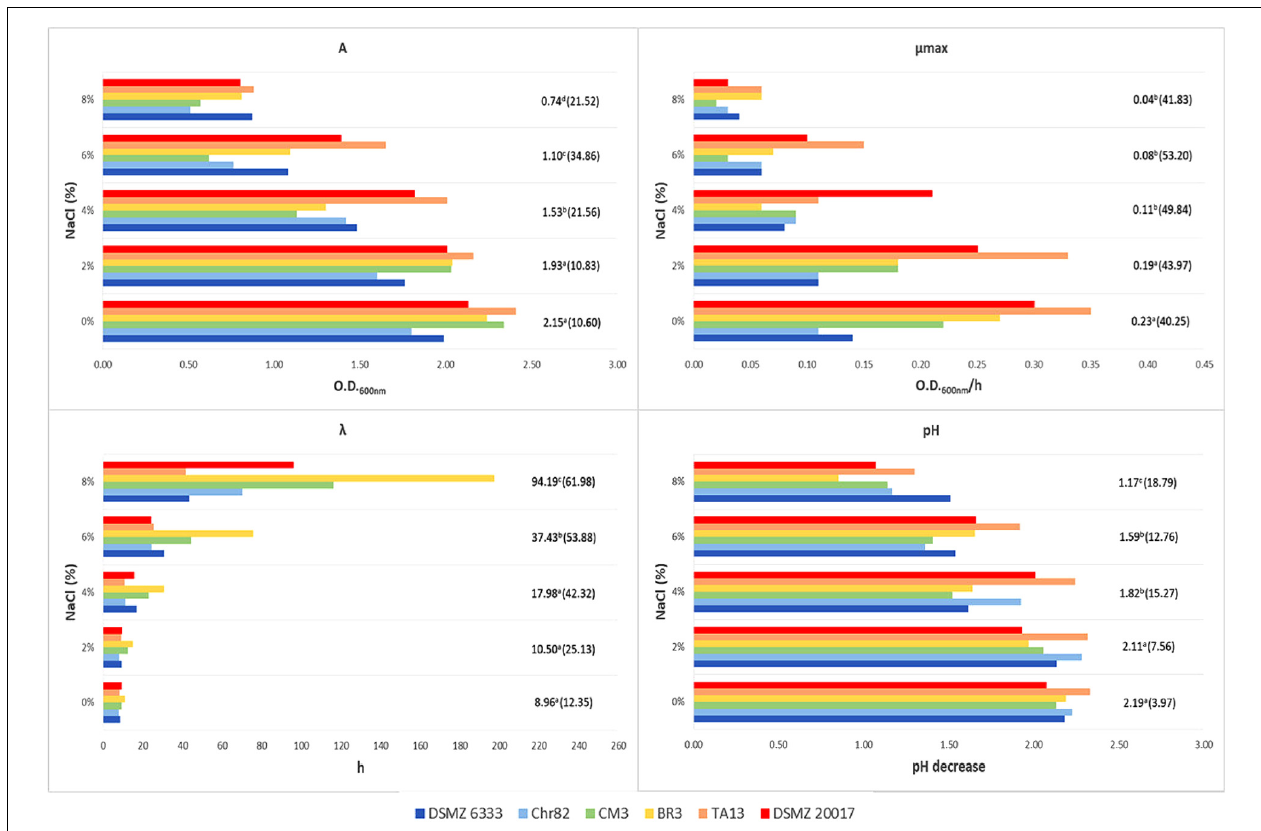
FIGURE 3 | Growth of L. sakei strains in MRS at different salt concentrations: estimates of the Gompertz parameters and pH decrease (initial value about 6.0). A represents the maximum OD 600 value reached, µ max is the maximum OD 600 increase rate in exponential phase and λ is the lag time. For each NaCl concentration, the mean value is reported and the relative coefficient of variation is indicated between brackets. Means with the same letter are not statistically different ( P > 0.05) according to the post hoc (LSD test) comparison of